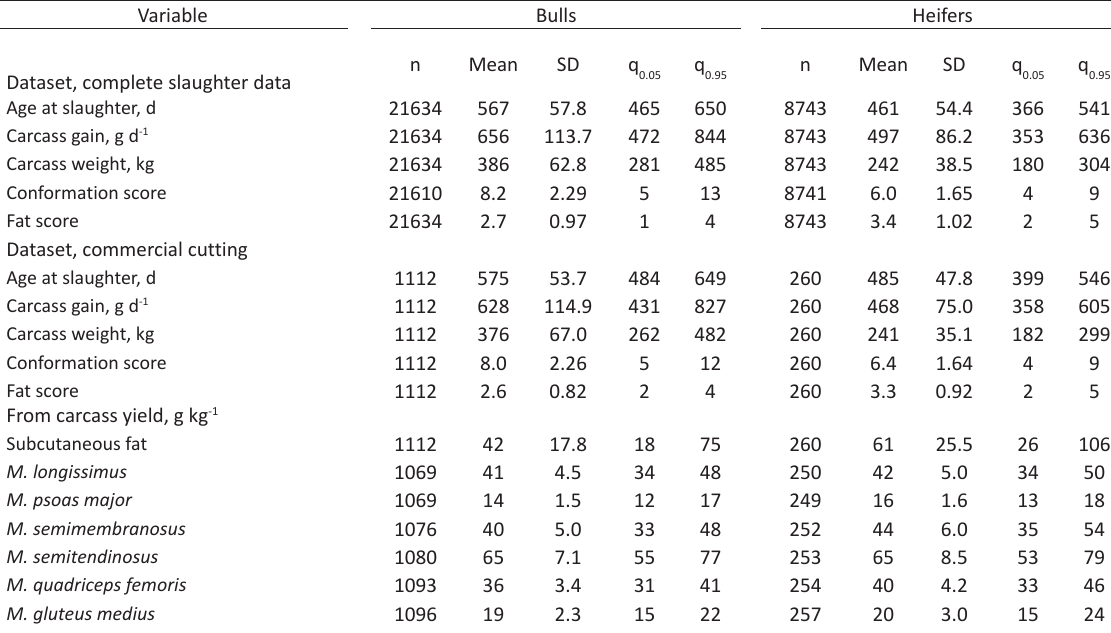
Table 1. Description of the experimental data Variable